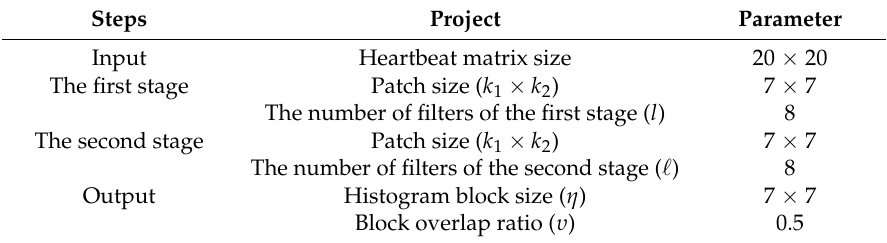
Table 1. Detailed parameter information of PCANet used for ECG